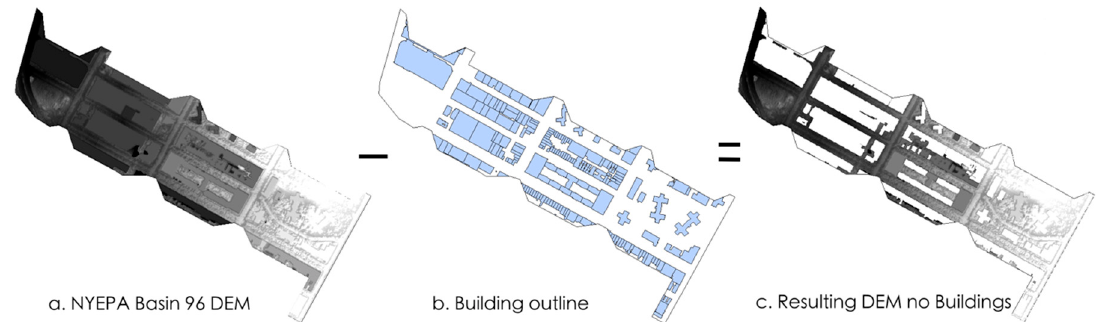
Figure 2. Building outline removal process from DEM file for NYEPA Basin-96 – a. Original DEM file with no extractions b. Buildings/structures location within the basin c. Resulting DEM file with no buildings.